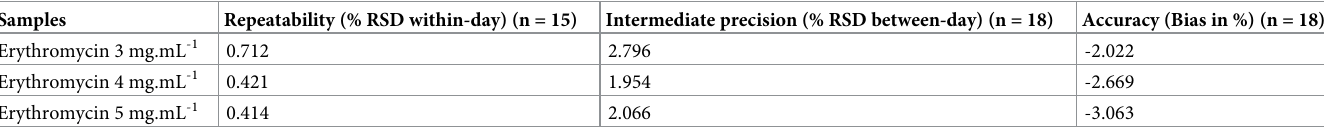
Table 2. Repeatability, intermediate precision and accuracy.